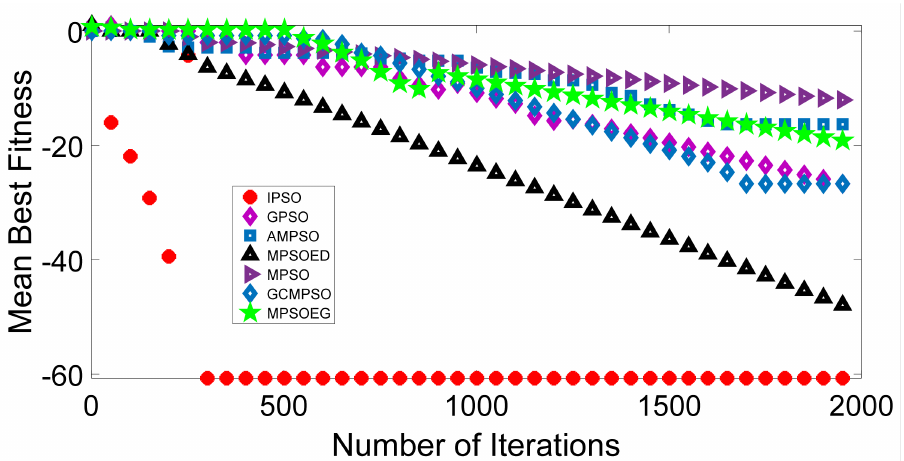
Figure 2. Algorithms convergence plots on f 5